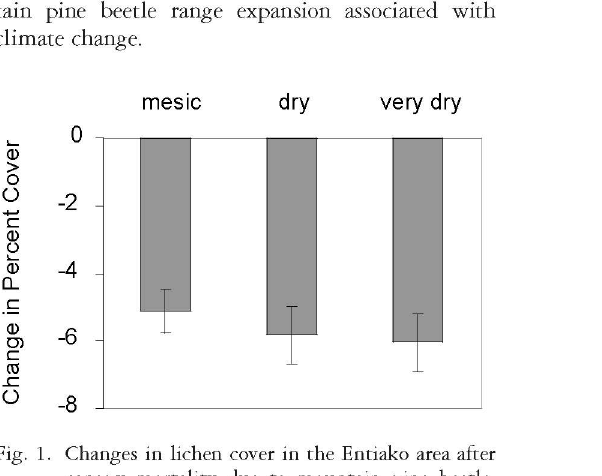
Fig. 1. Changes in lichen cover in the Entiako area after canopy mortality due to mountain pine beetle, from 2001 to 2003 (Mesic: n = 50; Dry: n = 50; Very dry: n = 42; error bars indicate standard